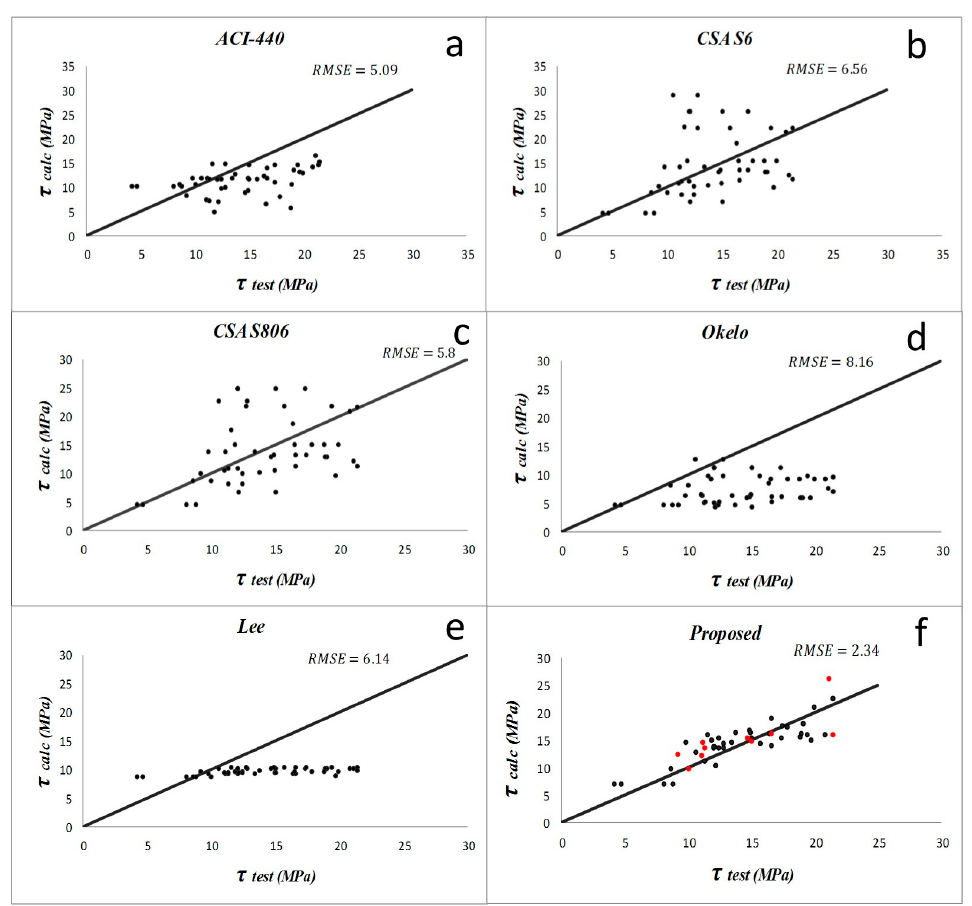
Figure 6. Bond strength prediction results by different models ( a – f ) on the normal concrete with sand-coated FRP bars (study group 2). The data used for validation are shown as red points in figure ( f ).